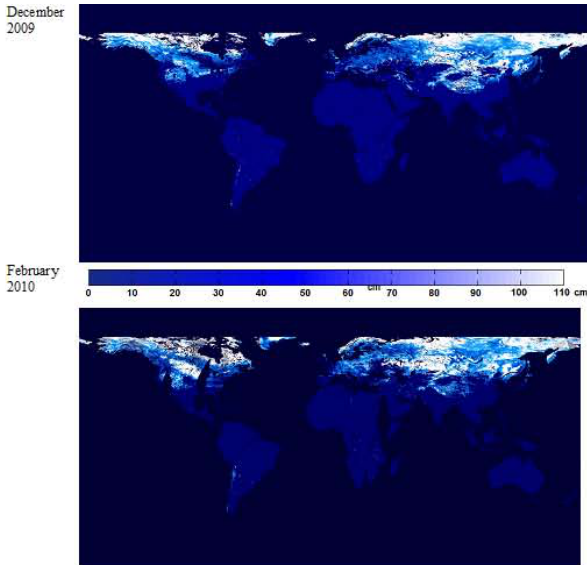
Fig. 14. SD map (in cm) of the entire world obtained by HydroAlgo in December 2009 and February 2010. The greater snow cover in Europe in February is evident. Some AMSR-E scans are missing, as we can see in Africa and North America in February 2010.